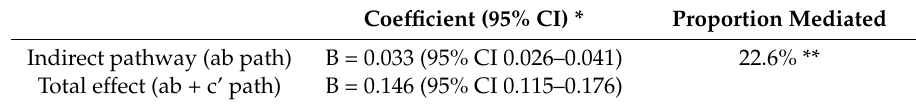
Figure 3. Mediation analysis on the association of HSI with incident type 2 diabetes. (a)–(c) are the regression coefficients between variables. The indirect effect is calculated as a × b. Total effect (c) is a × b + c’. Magnitude of mediation is calculated as indirect effect divided by total effect. Table 6. Mediating effect of BCAAs on the association of HSI with incident type 2 diabetes.